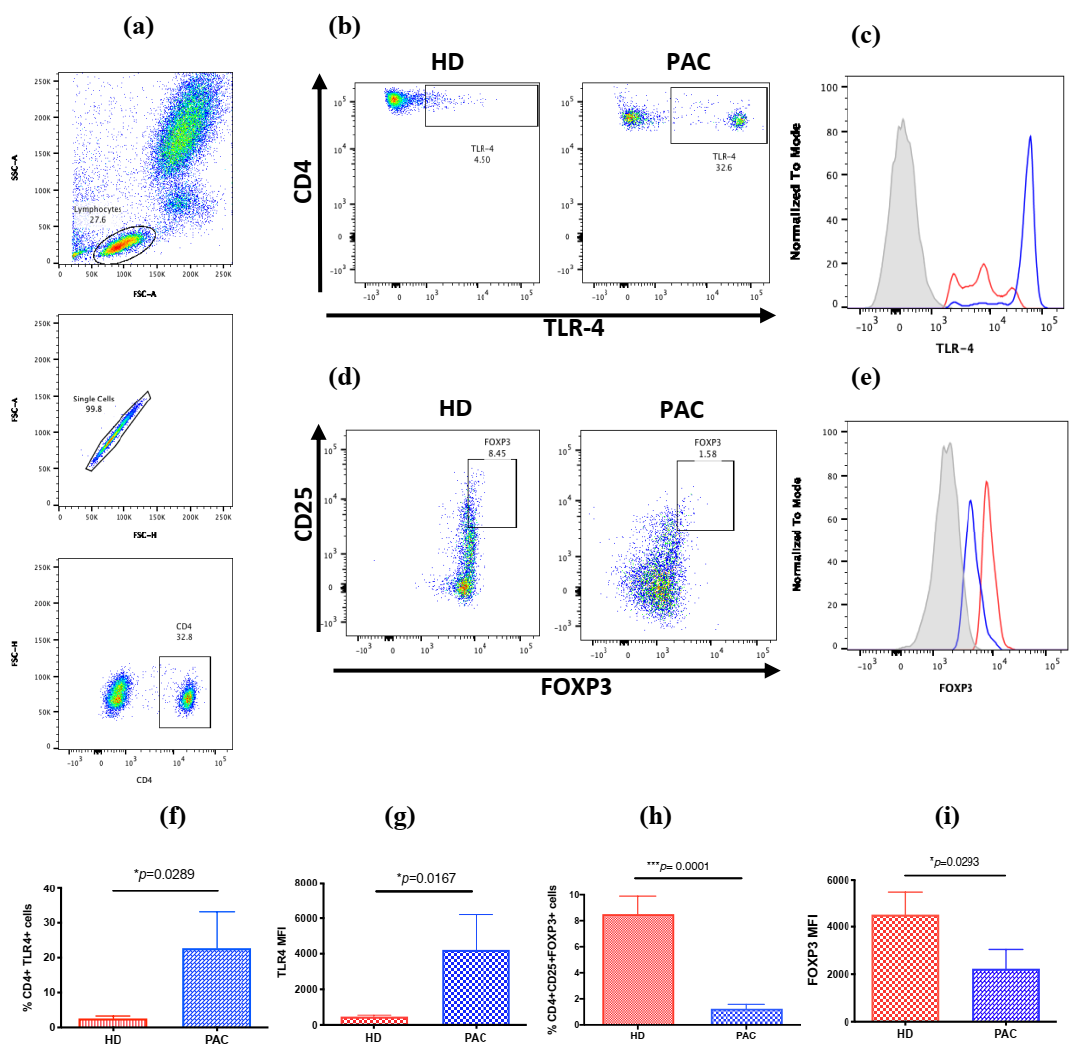
Figure 1. TLR4 expression in CD4 + T cells and CD4 + CD25 + FOXP3 + T reg cell subset. ( a ) Both subsets of cells were analyzed from the lymphocyte population through the selection of singlets and gathering of CD4 + T cells; ( b ) representative dot plots, showing the frequency of CD4 + TLR4 + T cells in peripheral blood from patients diagnosed with PAC, compared to healthy donors (HD); ( c ) the TLR-4 expression in CD4 T cells is higher in PAC patients (blue line) than in HD (red line); ( d ) representative dot plots showing the frequency of CD4 + CD25 + FoxP3 + in PAC patients, compared with that in HD; ( e ) the FOXP3 expression in CD4 T cells is lower in PAC patients (blue line) than in HD (red line); ( f ) percentage of CD4 + TLR4 + cells in the peripheral blood of HD and PAC patients; ( g ) the TLR4 expression in the CD4 + T cells of HD and PAC patients; ( h ) the percentage of CD4 + CD25 + FOXP3 + cells in the peripheral blood mononuclear (PBMC) in HD, compared to that in PAC patients; ( i ) the FOXP3 expression in the CD4 + CD25 + cells in the peripheral blood of HD and PAC patients. MFI, mean fluorescence intensity. Cytometry figures performed in FlowJo software version 10 (BD Biosences, CA, USA) * p ≤ 0.05; *** p ≤